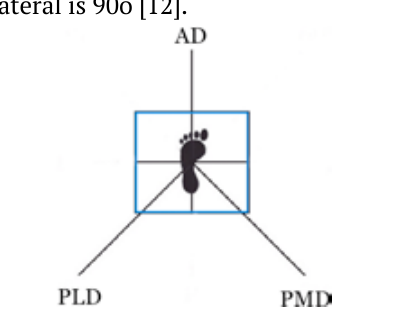
Figure 1. The direction of movement y balance test.